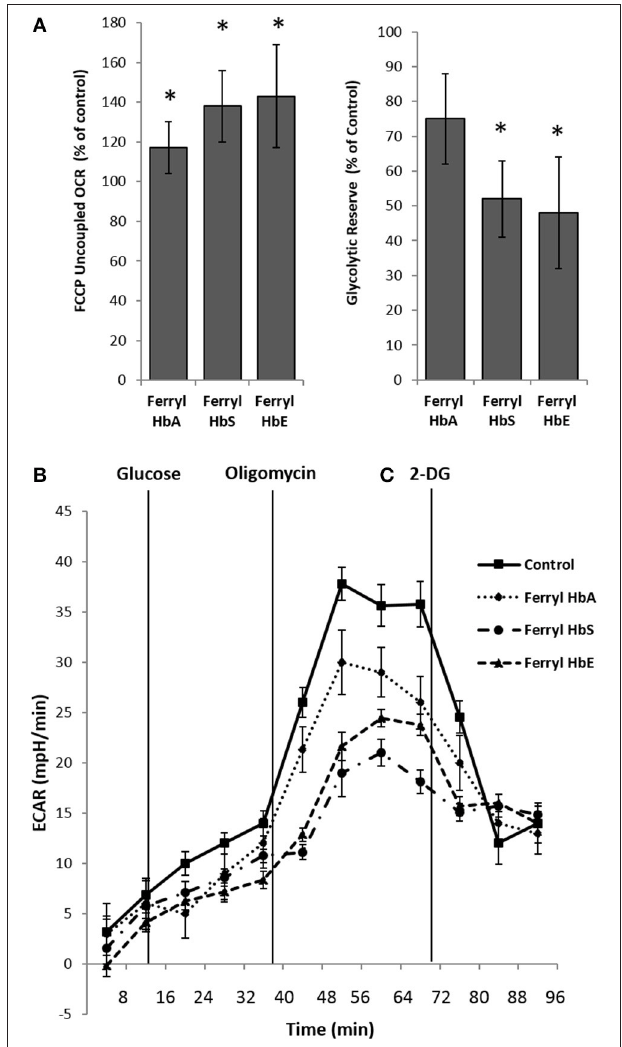
FIGURE 6 | Oxidized hemoglobins cause bioenergetic reprogramming in pulmonary endothelial cells. HPAEC were exposed to ferryl forms of HbA or HbS or HbE at equimolar concentration (100 µ M) for 12h. Mitochondrial oxygen consumption rates (OCR) and extracellular acidification rates (ECAR) were measured in real time using XF24 extracellular flux analyzer. (A) Average maximal OCR values expressed as % of control in HPAEC obtained after uncoupling of mitochondria following FCCP treatment ( N = 3). (B) Average glycolytic reserve capacity expressed as (%) of control in HPAEC ( N = 4) (C) representative ECAR plots of ferryl Hb treated HPAEC from an individual set of experiment repeated three times. Statistical significance between means was calculated by paired Student’s t -test. * P < 0.05 vs. untreated control.